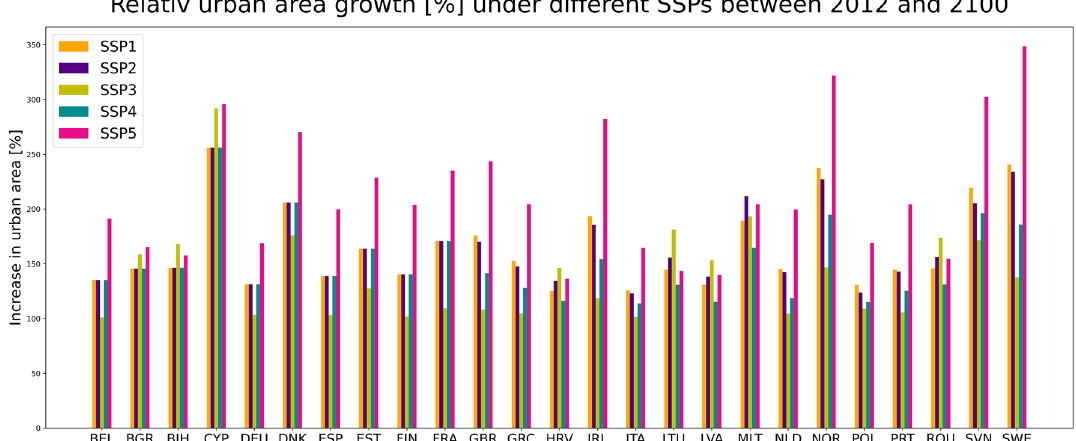
Figure 3. Increase in relative urban extent under the five different SSPs in all EU coastal countries between 2012 and 2100.